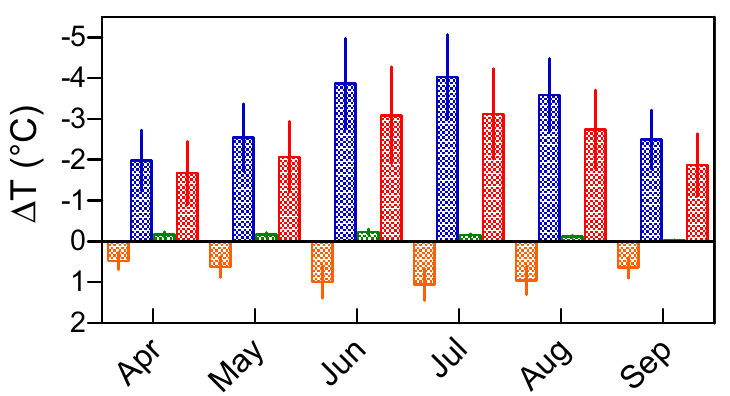
Figure 6. Components of monthly changes in surface temperature (red bar ± SD) in the afforestation scenario: shortwave radiative forcing effect due to albedo change (brown bar ± SD), energy redistribution associated with changes both roughness (blue bar ± SD) and Bowen ratio (green bar ±